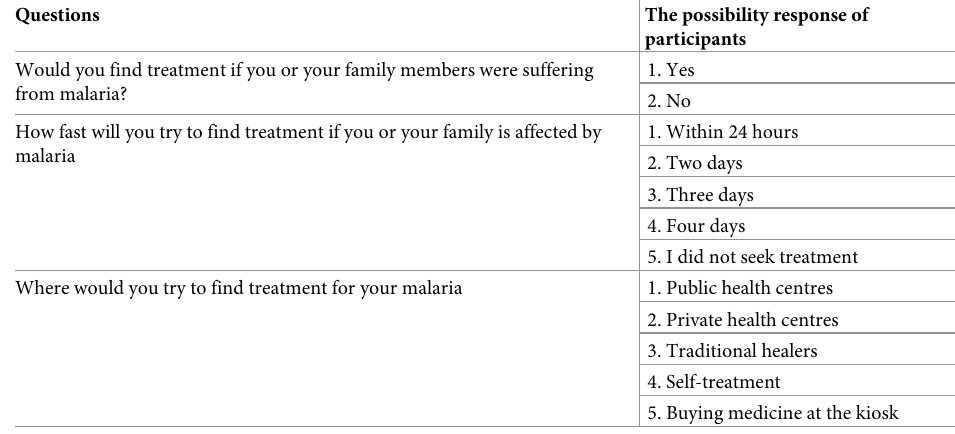
Table 1. Questions used to explore understanding of treatment-seeking behaviour of